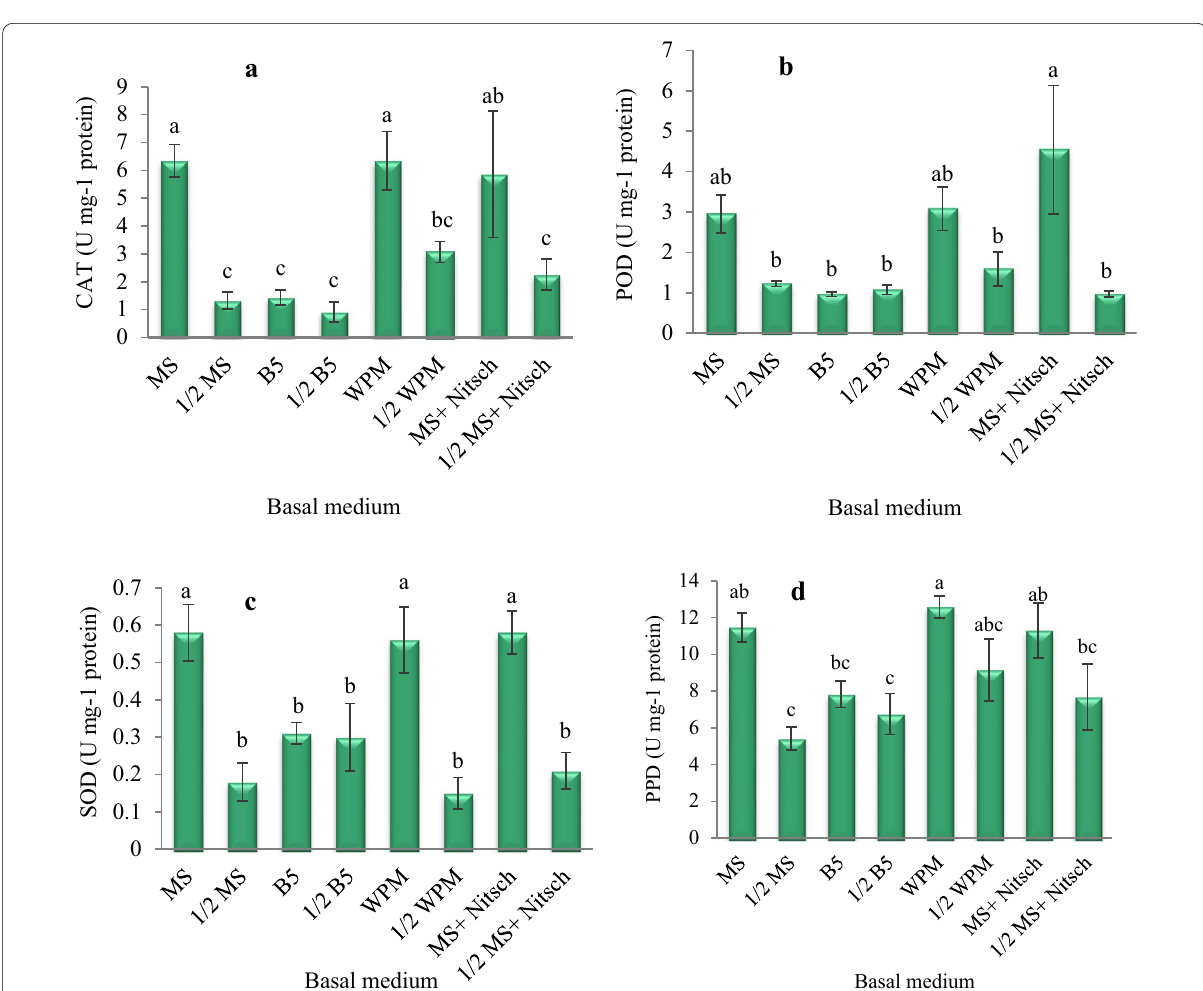
Fig. 5 The effect of the basal medium on antioxidant enzyme activity in the Corylus avellana callus cultures; a CAT activity, b POD activity, c SOD activity, d PPD activity. According to Duncan’s multiple range tests, values with common letters are not significantly different at the 5% probability